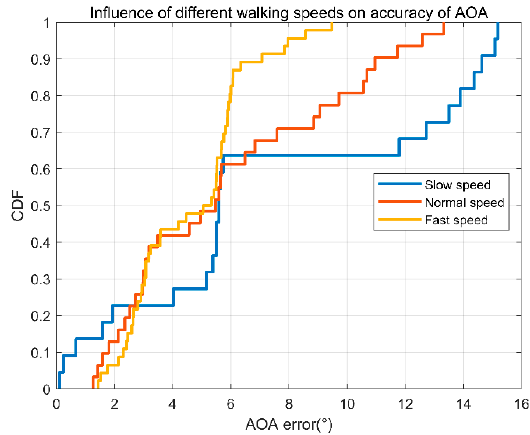
Figure 15. AOA error accumulation diagram of three different walking Speeds. (3) Different sampling rates.